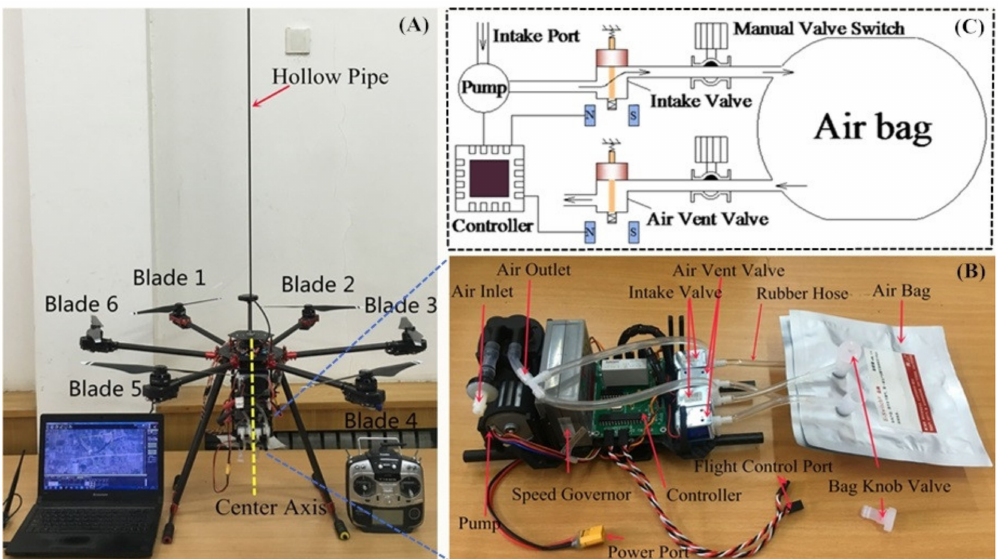
Figure 1. ( A ) The yellow dotted line is the center axis and air intake hollow pipe (AIHP) was mounted on the center axis. Six blades are shown on the picture. ( B ) An image of the gas sampling equipment (GSE). ( C ) The gas collection schematic and the state of each part during the original gas was replaced by the gas from the target location using the